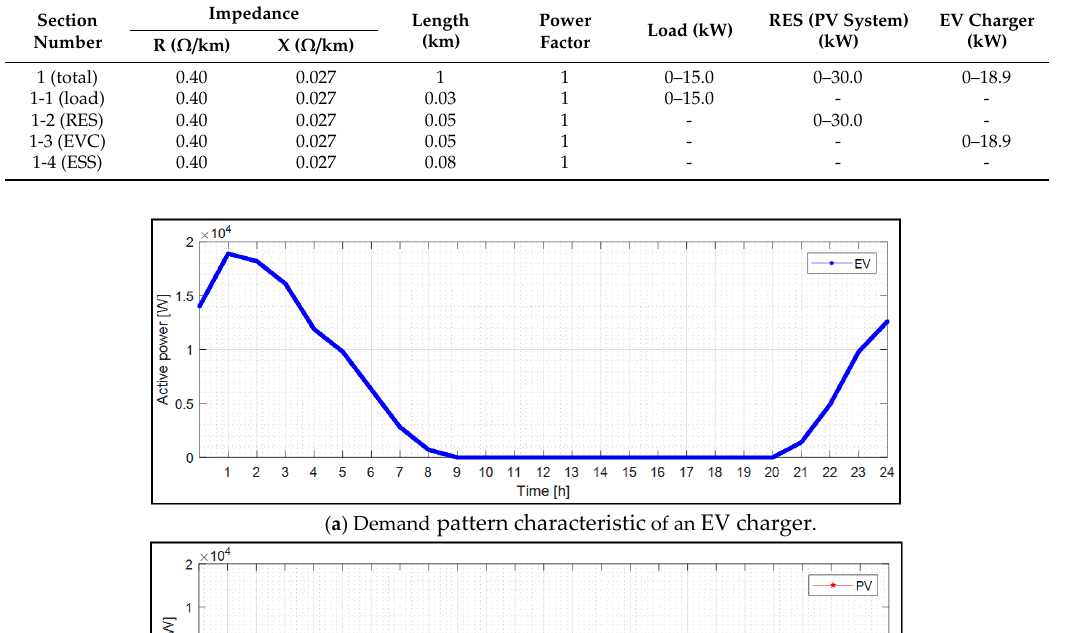
Figure 17. Configuration of the secondary feeder with EV infrastructure. Table 3. Simulation data.